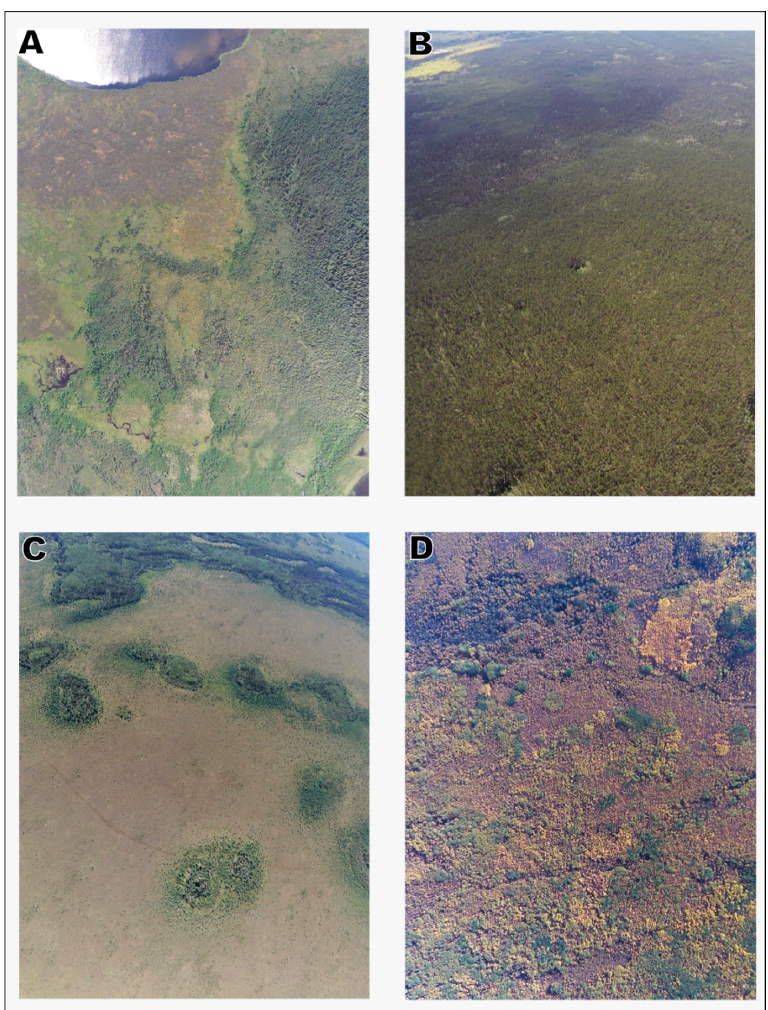
Figure A1. Aerial pictures of study area and typical landscapes across differing ecodistricts (see Figure 1). Panel ( A ) small lakes mixed with open bogs, treed bogs, and upland conifer in the Buffalo River Plains; ( B ) continuous pine and mixed conifer in northern Knight Creek Plain ecodistrict; ( C ) extensive open rich fens mixed with upland islands in the Fox Lake Plain; ( D ) continuous deciduous forest on well-drained slopes with low peatland abundance (Figure 4) in the Birch Hills Fans. Photos in panels ( A ) and ( C ) were taken 300 m above ground level; ( B ) and ( D ) were taken 700 m above ground level.